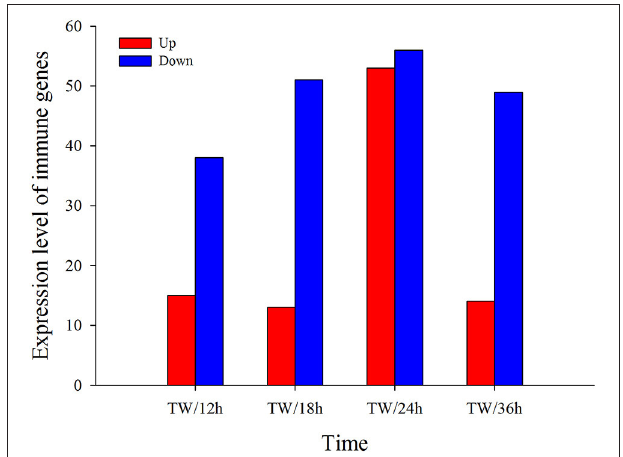
FIGURE 1 | Screening of immunity-related DEGs in response to I. fumosorosea at 12, 18, 24, and 36 h post-infection.